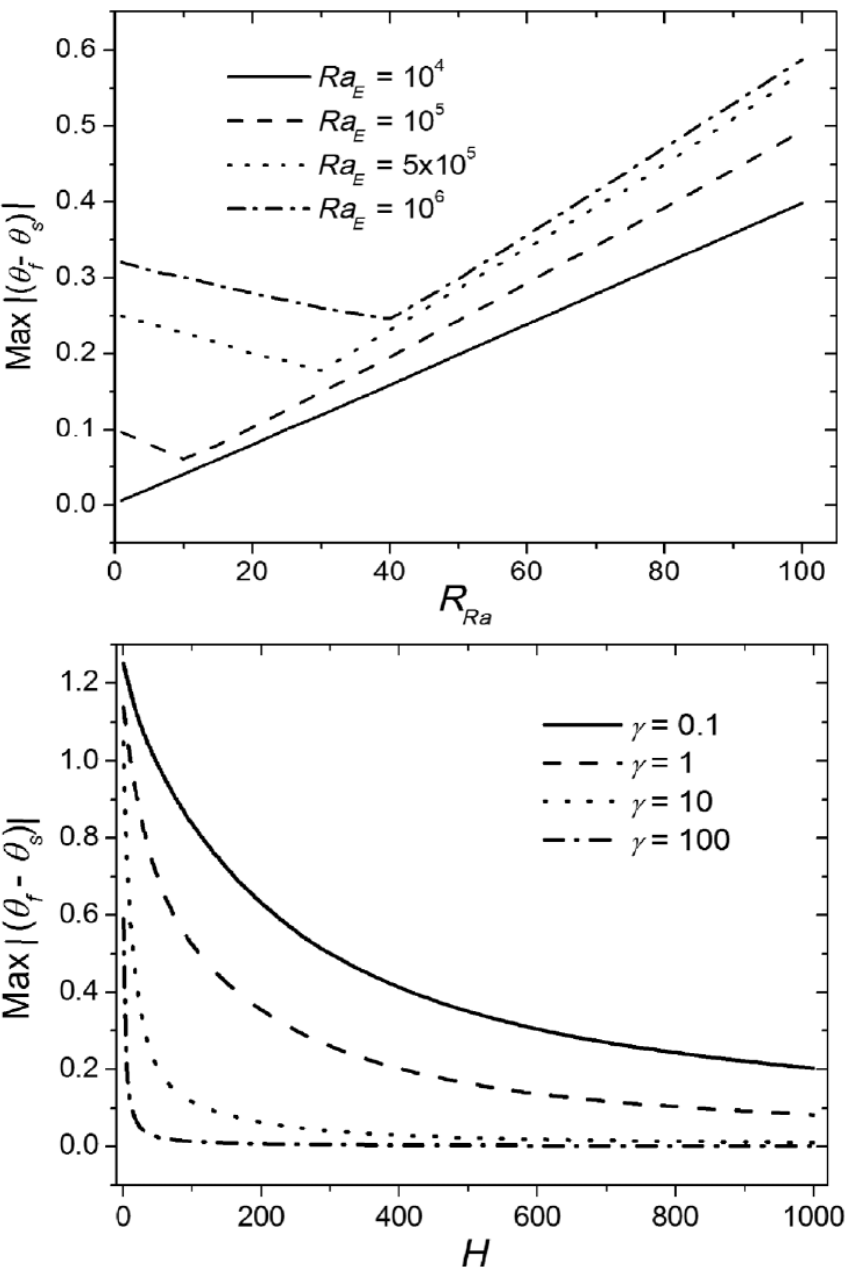
(cid:12) (cid:12) (cid:12) θ f − θ s (cid:12) ) versus ( Top ) internal-to-